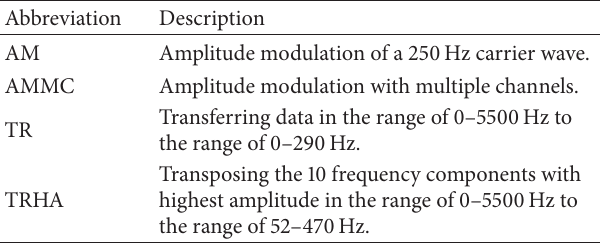
Table 2: The four algorithms used to process the sounds in the laboratory